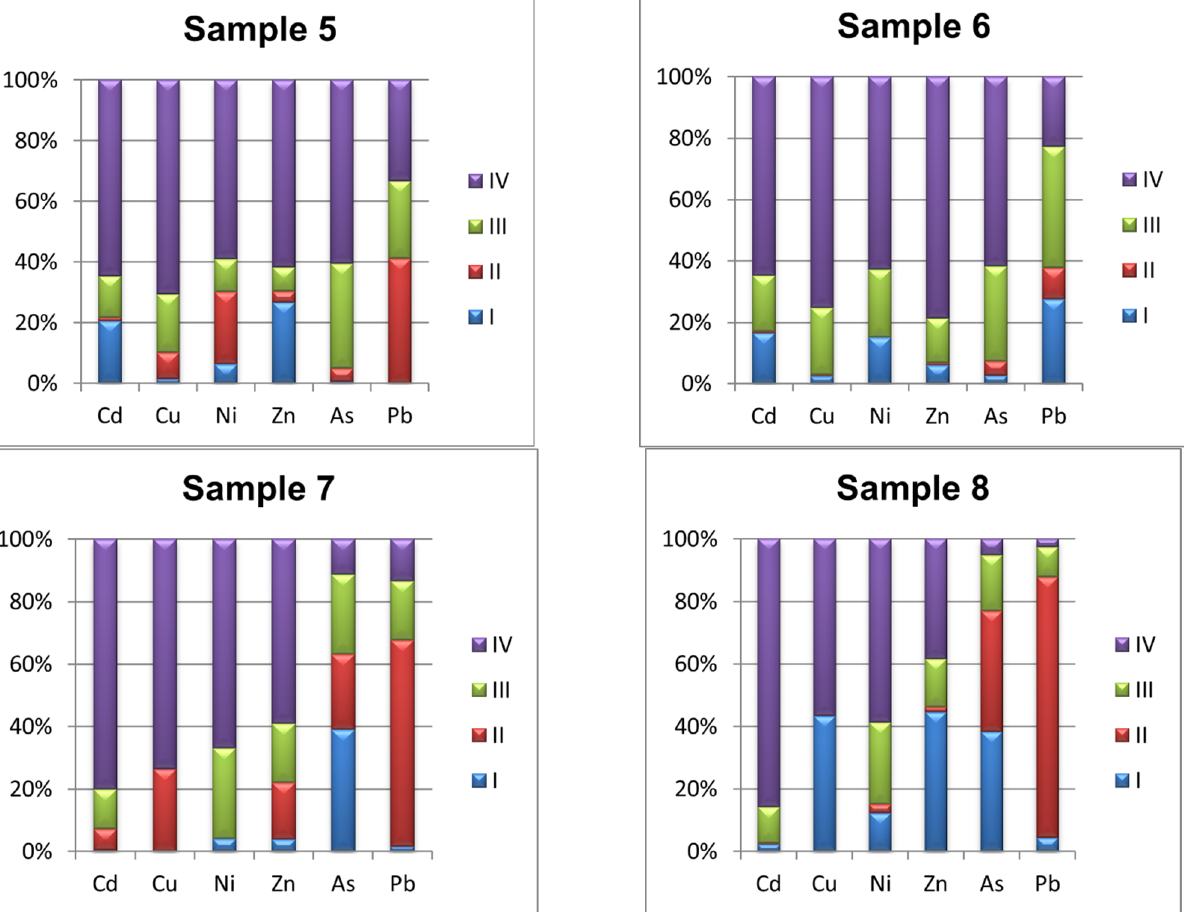
Figure 3. Distribution of metals in soil samples as determined by a modified BCR sequential extraction procedure. BCR 1 (blue)—mobile fraction, BCR 2 (red)—reducible fraction, BCR 3 (green)—oxidizable fraction, and BCR 4 (violet)—residual bound.